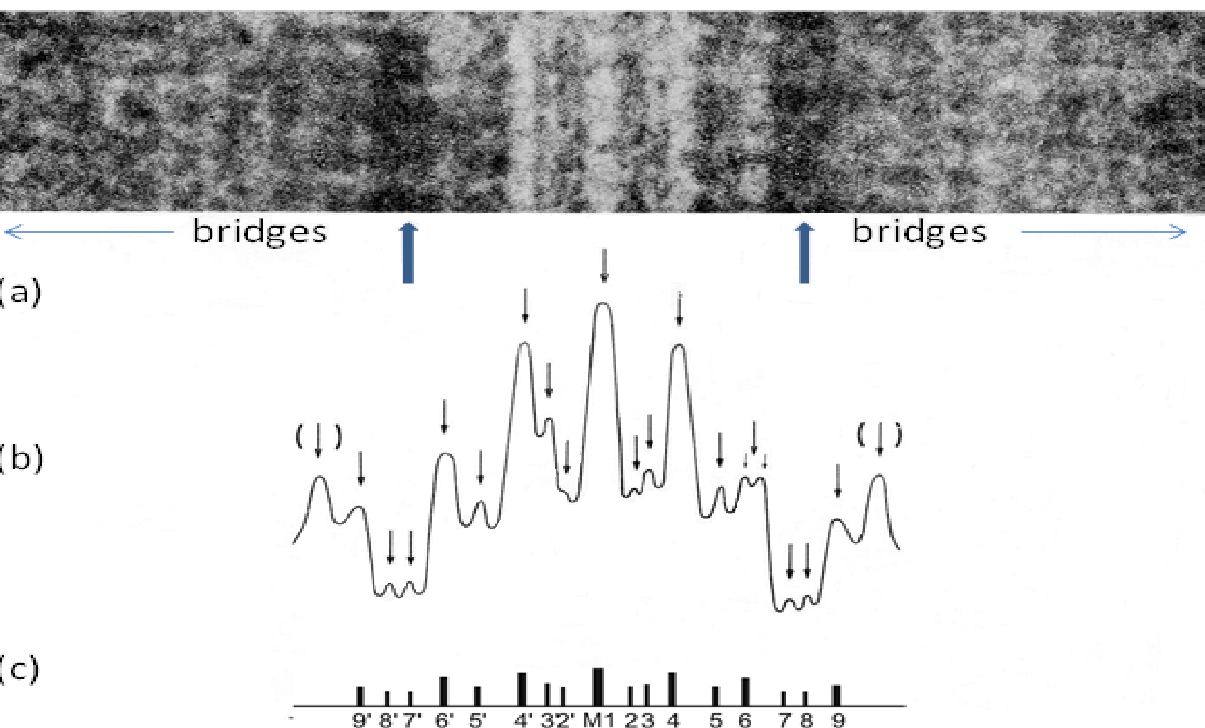
Figure 8. ( a ) Enlarged region of a longitudinal cryo-section of the A-band in human m. tibialis anterior showing the central M-band lines, the flanking bare regions (strong arrows) and the starts of the two bridge regions. Protein is white in this figure. ( b ) Density profile through the middle of the micrograph in ( a ) showing the prominent M-bridge densities. The main M-bridges are labelled as in ( c ). (Adapted from [20] with permission from